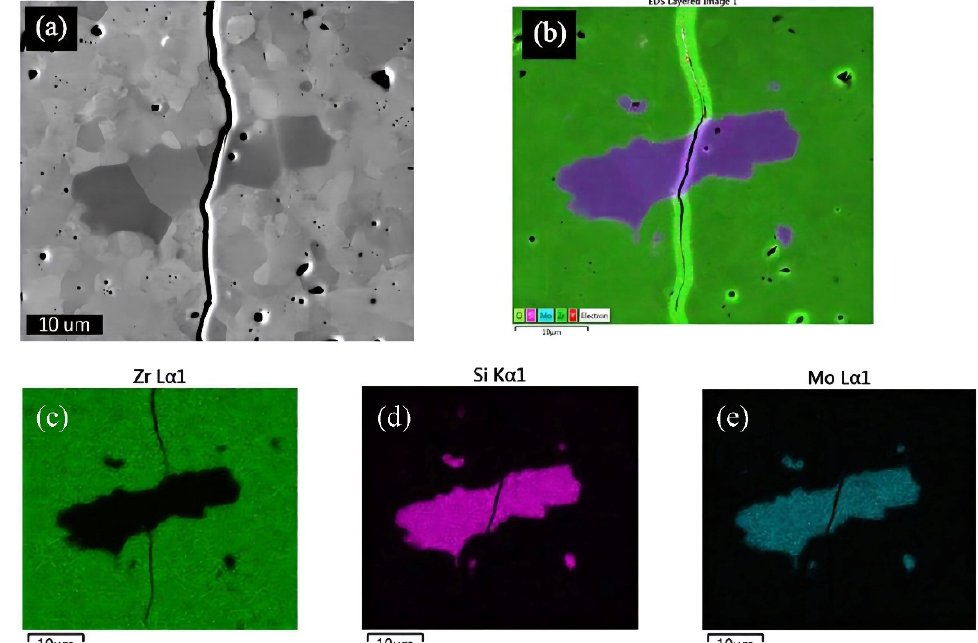
Figure 12. A crack passing through a particle in a composite sample containing MoSi 2 . BSE image